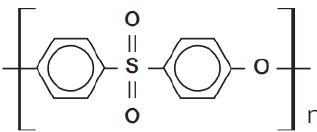
Figure 1. Molecular structure of the polyethersulfone (PES).